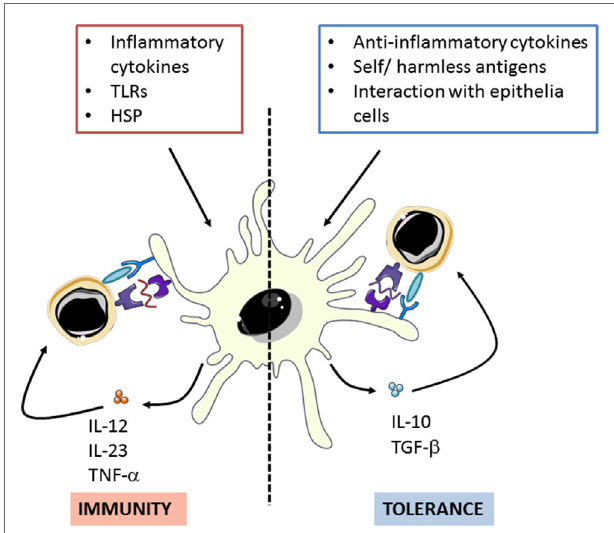
FigURe 1 | Dendritic cells can polarize immune response though promote both pro- and anti-inflammatory activities in response to different stimuli. Adapted from: O’Neil et al. (26). TLRs: toll-like receptors, HSP: Heat shock proteins.